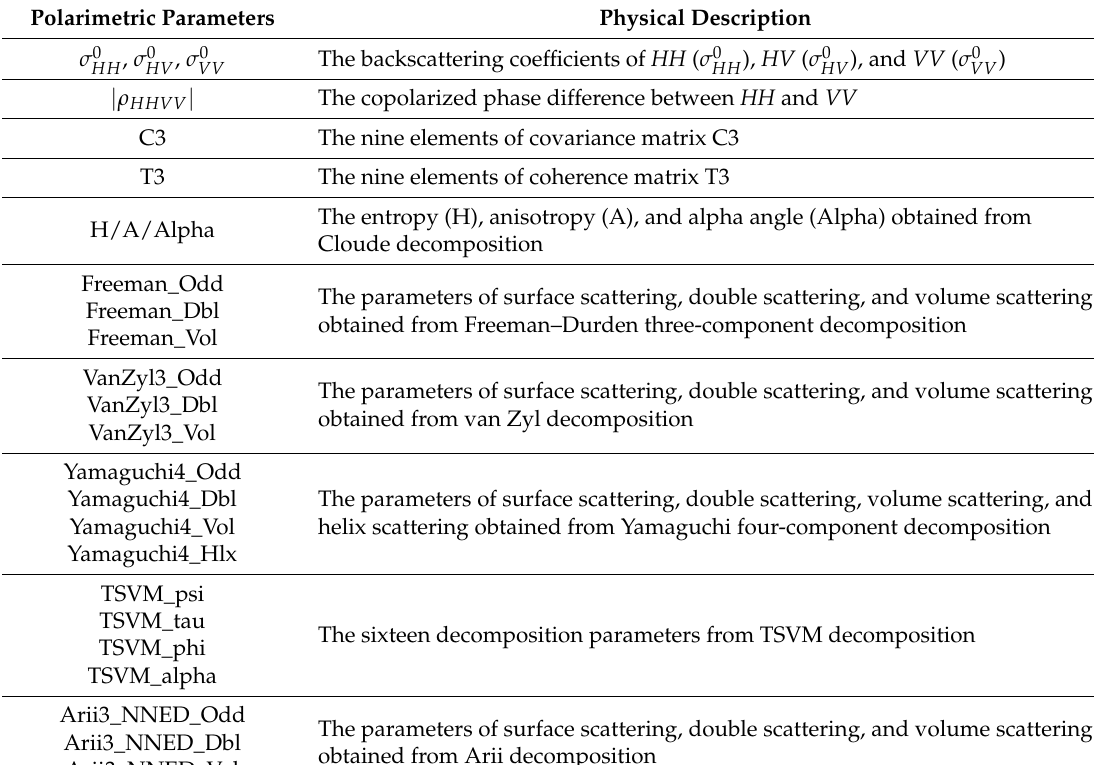
Table 1. A summary of the polarimetric parameters used in this